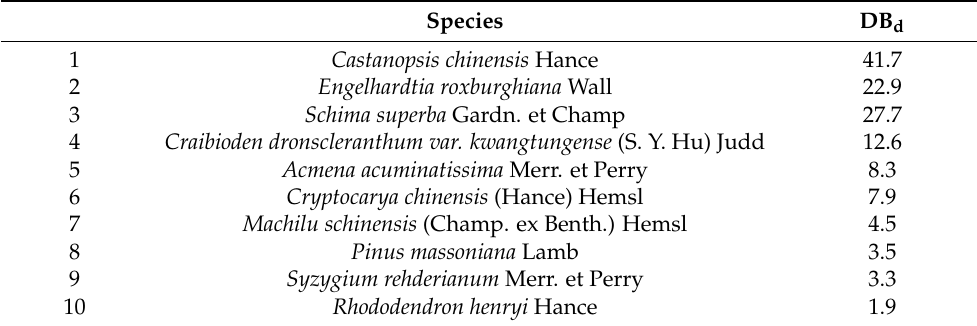
Table 2. Biomass storage (DB d in t) by dead tree species of the top 10 individuals in a 20 ha sub-tropical forest plot.